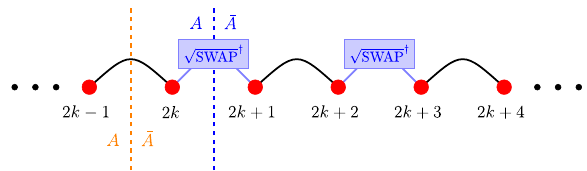
Fig. 4 Bipartitions with different choices of boundary. Atom pairs connected with black line are Bell pairs. The dotted lines denote the boundary between A and A